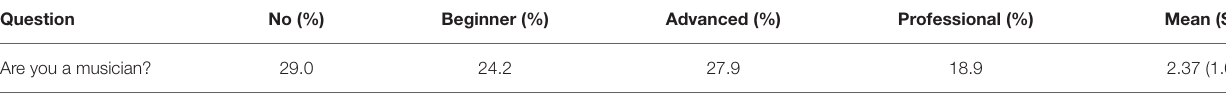
TABLE 3 | Musicianship of the participants. Question